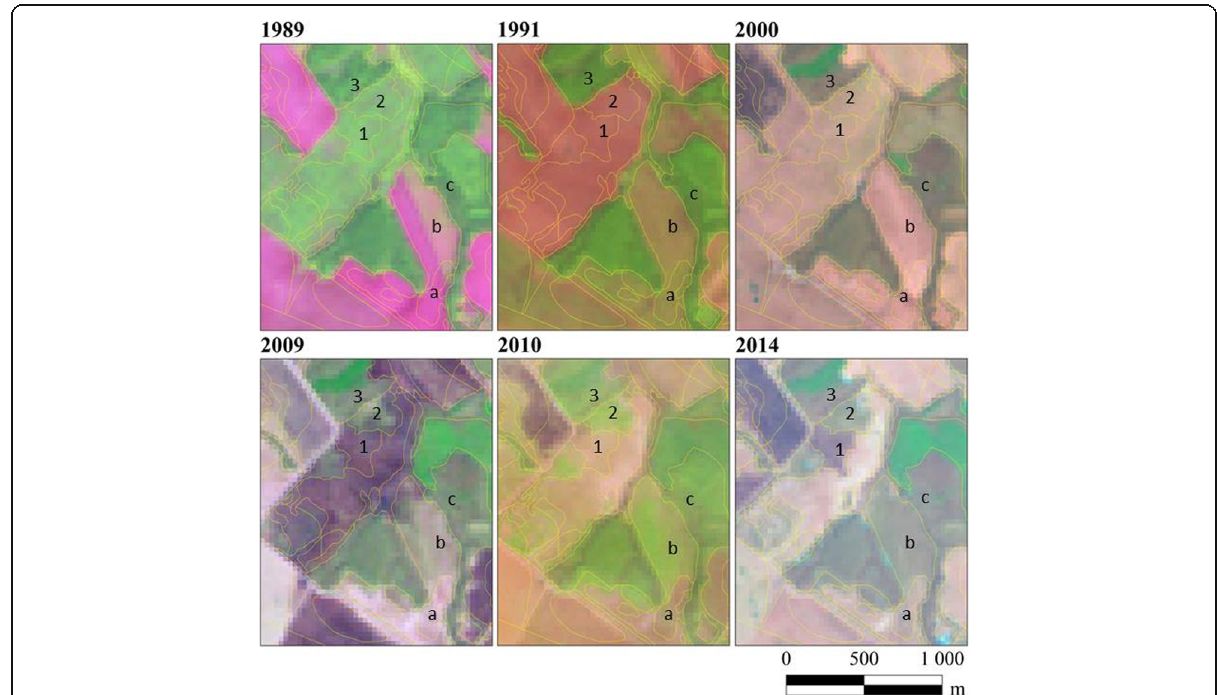
Fig. 2 Series of the 6-year Landsat images of the study area at the local scale: 1, 2, and 3 are biotopes of site 1 and a, b, and c are biotopes of site 2. Green and gray patches are forests (coniferous trees and deciduous trees with and without leaves, respectively), pink and brown patches are arable fields, and black and purple are burnt areas (Landsat — Glovis